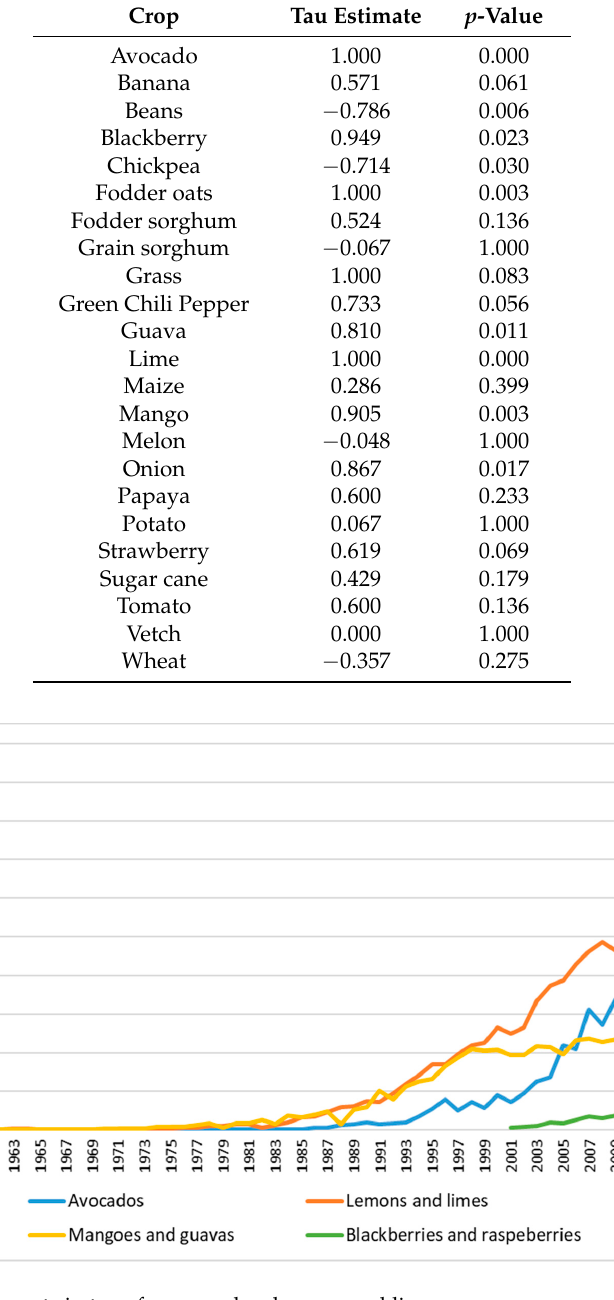
Figure 3. Mexican exports in tons for avocados, lemons and limes, mangoes, guavas, blackberries, and raspberries from 1961 to 2016 [36,37].